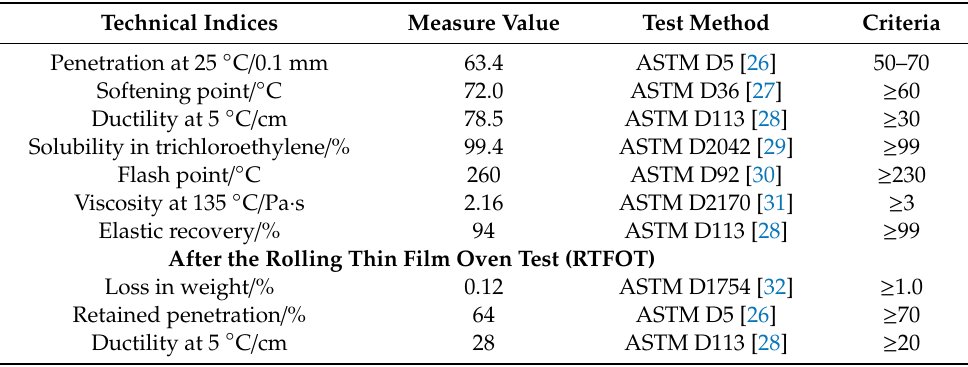
Table 2. Basic properties of SBS modified